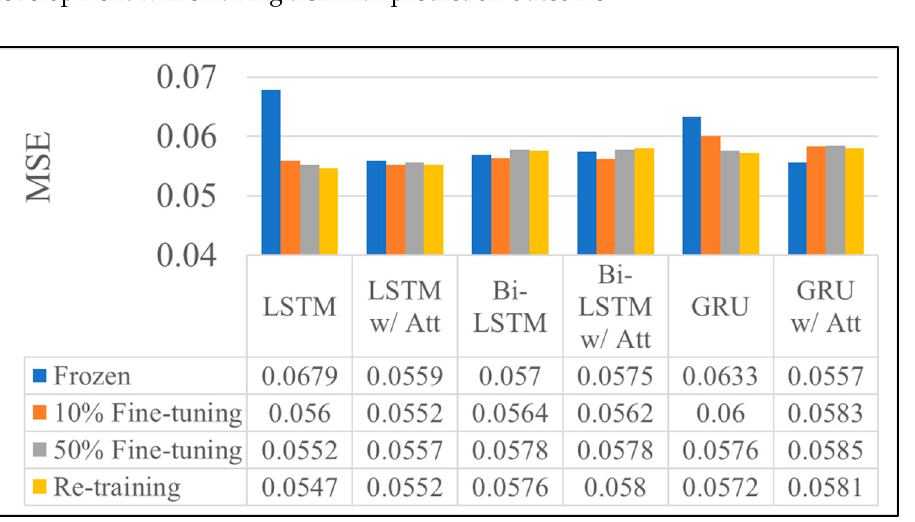
Figure 14. MSE of the target disease course prediction of TL-CDC with attention mechanism under k = 4.